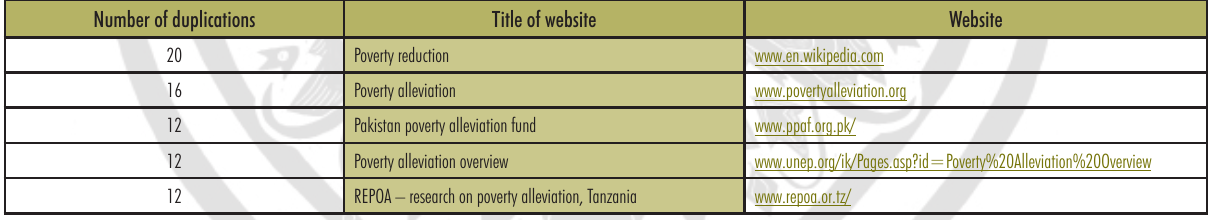
TABLE 2: TOP FIVE RESPONSES FOR THE GOOGLE SEARCH POVERTY ALLEVIATION Number of